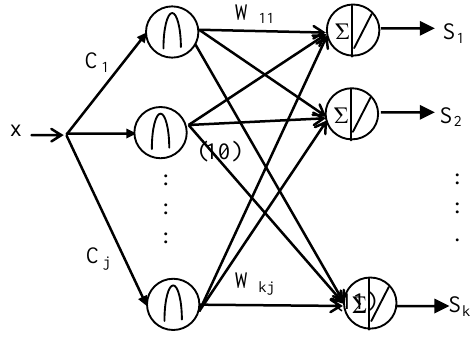
Fig. 3. RBF neural network